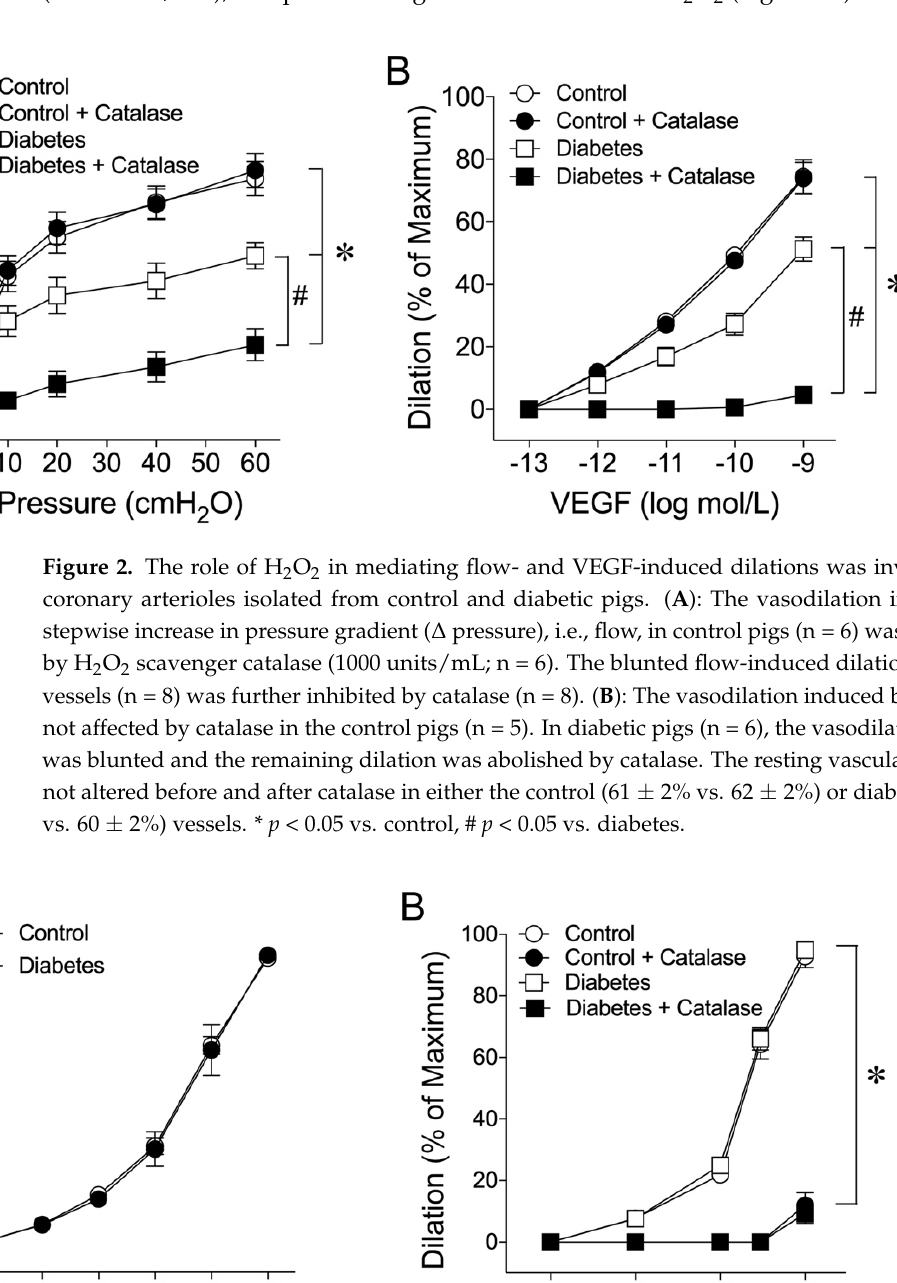
Figure 3. Responses of coronary arterioles to NO donor sodium nitroprusside and H 2 O 2 . ( A ) Both the control (n = 5) and diabetic (n = 5) vessels dilated to sodium nitroprusside in a concentration- dependent manner without differences. ( B ) H 2 O 2 produced similar dilations in the control (n = 5) and diabetic (n = 6) vessels and catalase (1000 units/mL) abolished the dilations in the control (n = 5) and diabetic (n = 6) vessels in the same manner. * p < 0.05, control/diabetes vs. catalase treatment.